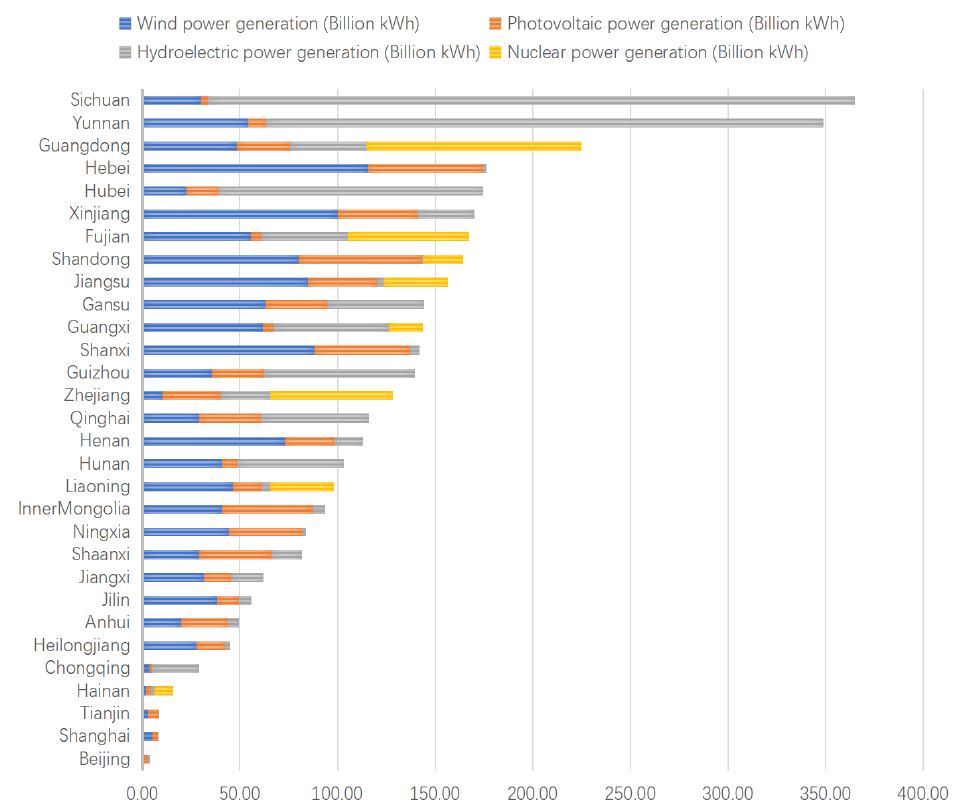
Figure 5. Clean energy development in China of